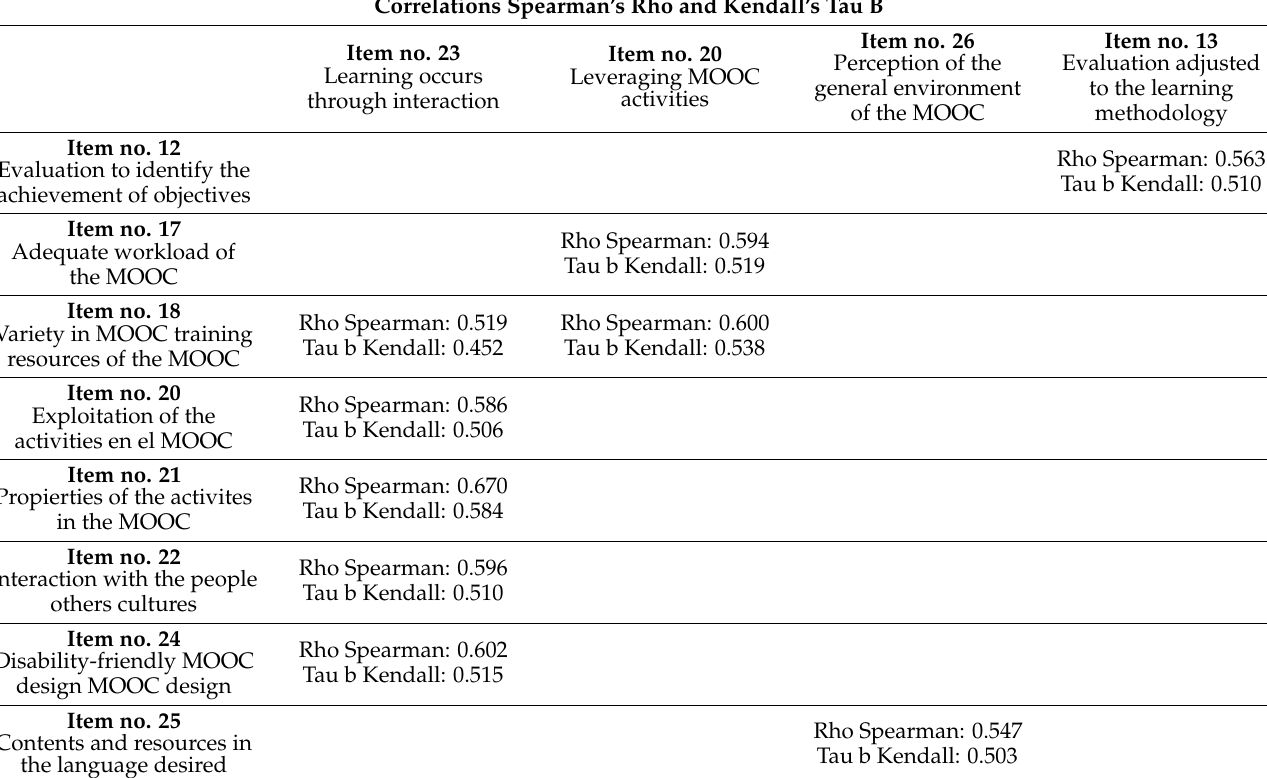
Item no. 23 Learning occurs through interaction